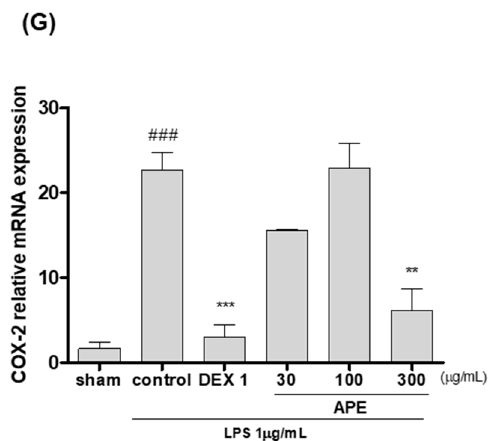
Figure 7. Effects of Andrographis paniculata extract on ( A ) cell viability and ( B ) LPS-induced NO generation and the expression of ( C ) IL-1 β , ( D ) IL-6, ( E ) TNF- α , ( F ) iNOS, and ( G ) COX-2 in RAW264.7 cells. Cell were treated with Andrographis paniculata extract (10, 30, 100, 300, and 1000 µg/mL) and LPS (1 µg/mL) for 24 h. ### p < 0.001 vs. sham, * p < 0.05 vs. control, ** p < 0.01 vs. control, *** p < 0.001 vs. control by one-way ANOVA, Dunnett’s test.